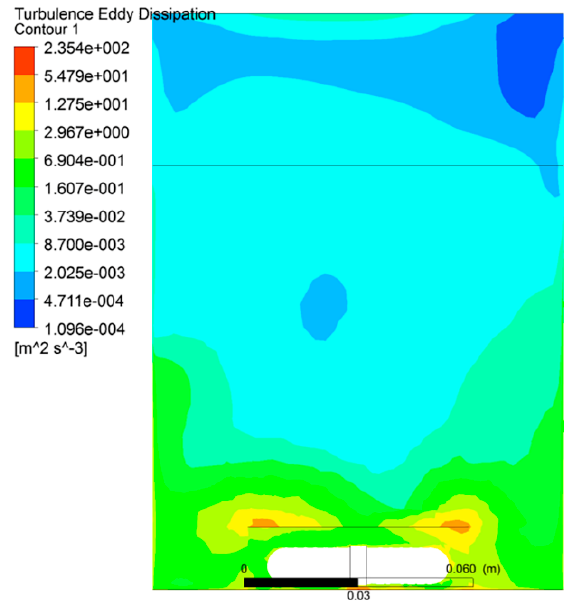
Figure 1. Turbulent intensity distribution in a beaker at 200 RPM.